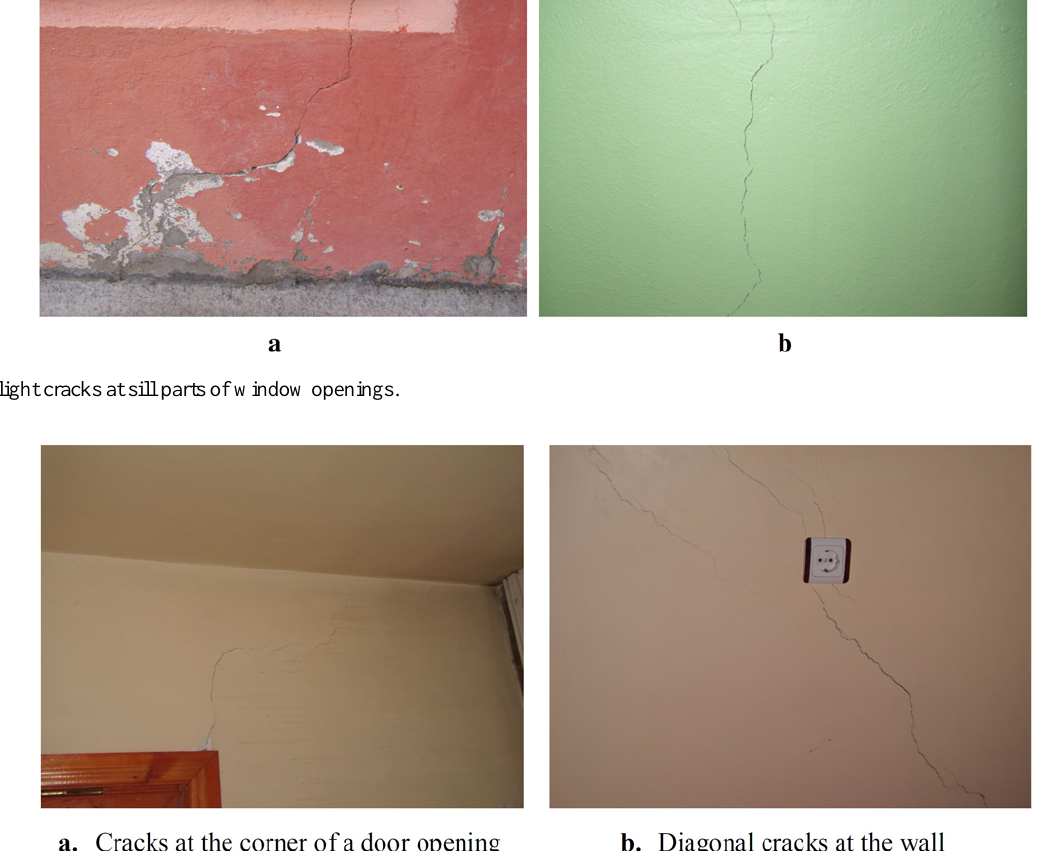
Fig. 28. Slight damages in a confined masonry